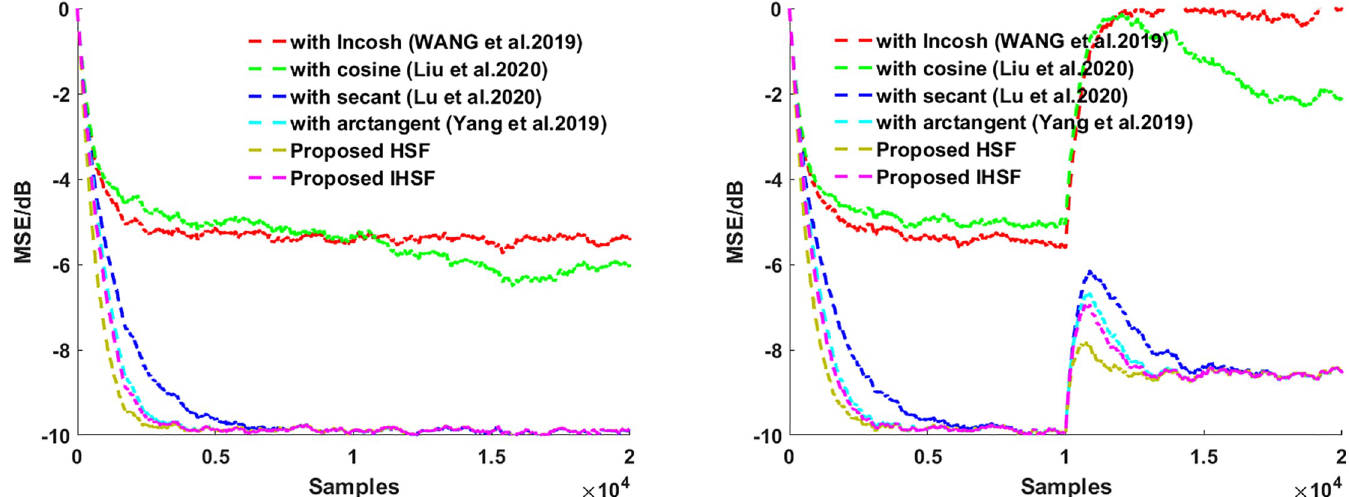
Fig 4. MSEs for the adaptive filtering algorithms by using hyperbolic functions. (left) with the uncorrelated input signal X UC ( n ); (right) with the correlated input signal X C ( n